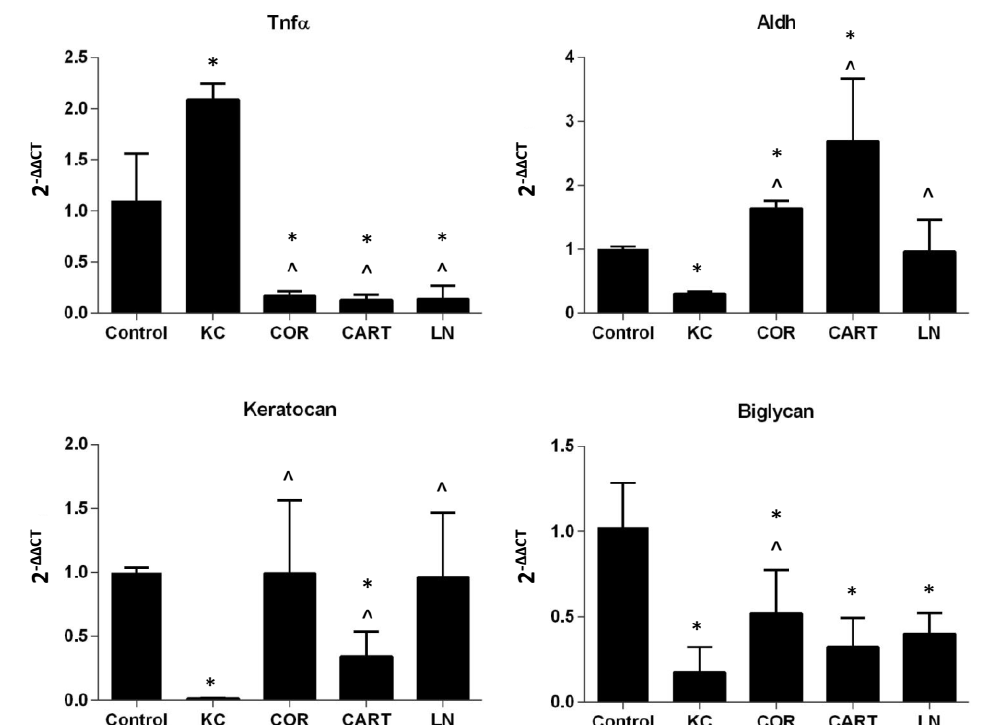
Figure 5. Gene expression of keratocytes after TDP treatment. Pro-inflammatory marker Tnf α , keratocyte markers Aldh , keratocan and Biglycan were evaluated in normal, KC and TDP treated corneas. n = 6 in each group, * refers to p < 0.05 compared to normal corneas, and ^ refers to p < 0.05 compared to KC corneas.